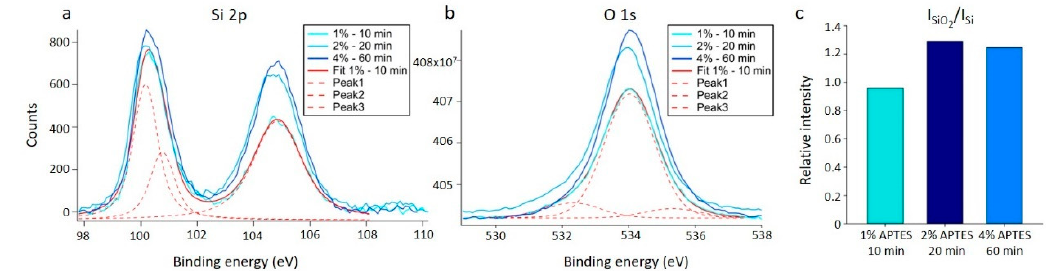
Figure 2. XP spectra results for crystalline silicon silanized with APTES using acetic acid as the silanization solvent. ( a ) Si 2p spectra. ( b ) O 1s spectra. ( a , b ) The results are displayed with the curve fitting results for the 1% APTES, 10 min silanization sample, which consisted of three separate peaks that combines to the overall fitted curve (Fit 1%—10 min). Similar curve fits were performed for the two additional silanization conditions, but the fitted curves to the data are not included in the graph. ( c ) Bar plot showing the relative intensities of the SiO2 peak at ~104.8 eV to the bulk silicon peak at ~100.5 eV. Results are calculated based on the fitted